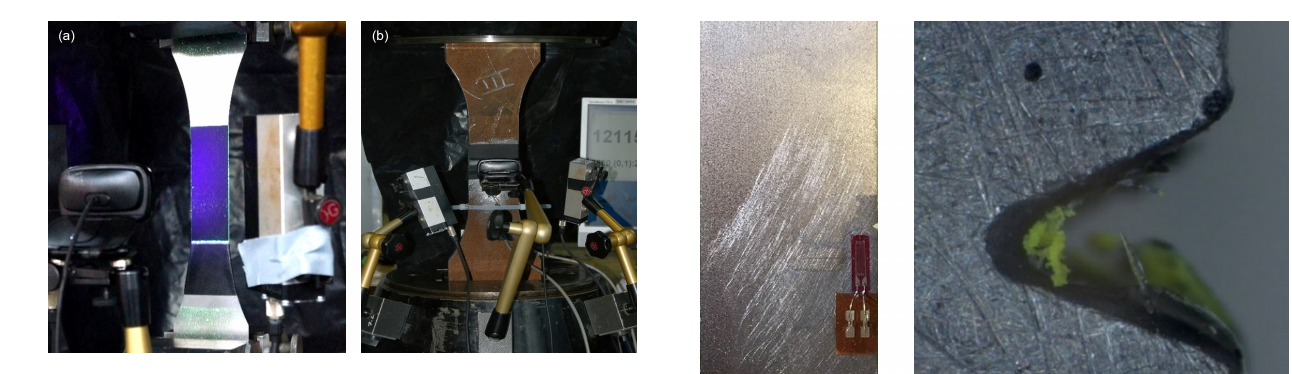
Figure 3. Tensile test setup of thin metal sheets with predefined notch (a) and weld (b) .